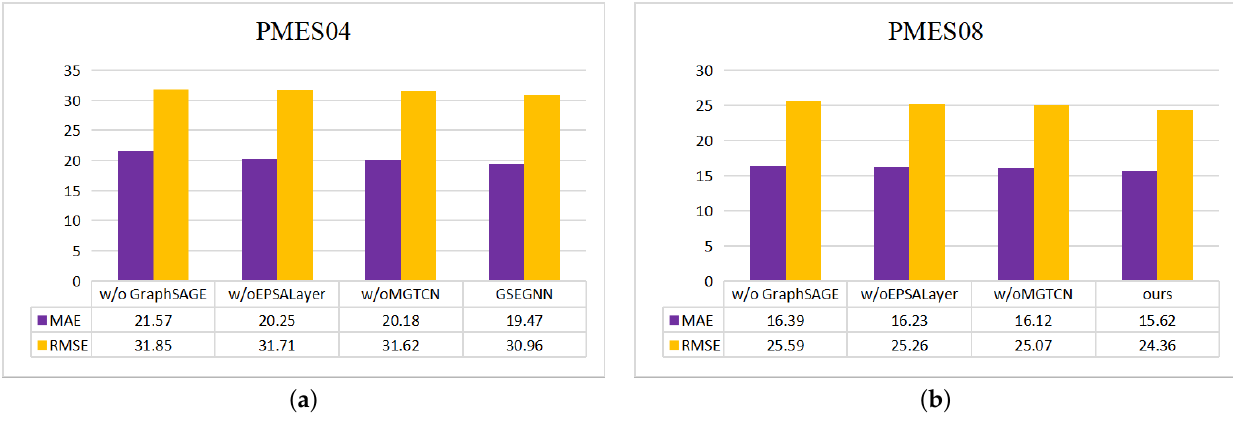
Figure 11. Experimental results of different ablation modules: ( a ) PMES04; ( b )